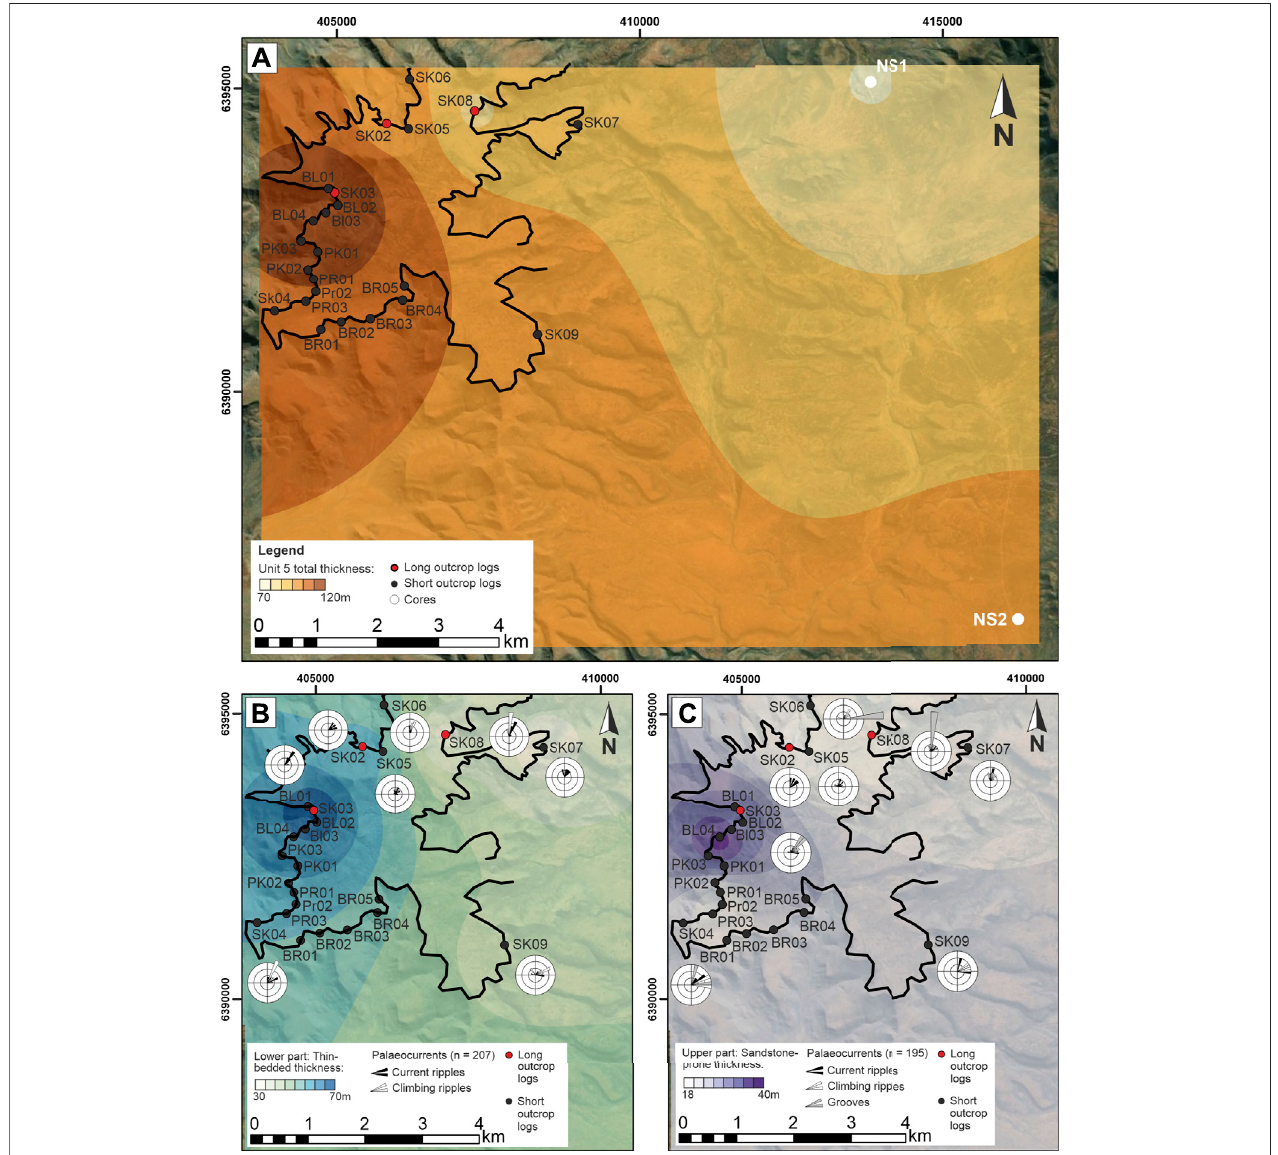
FIGURE 5 | (A) Unit 5 isopach map showing thickening to the NW; (B) Isopach map of the lower thin-bedded part showing thickening towards the W, with palaeo fl ow to the N and NE; (C) Isopach map of the upper sandstone-prone part showing thickening towards the W, with palaeocurrents indicating fl ow towards the N and NE. The black line indicates the outcrop belt of the upper division of Unit